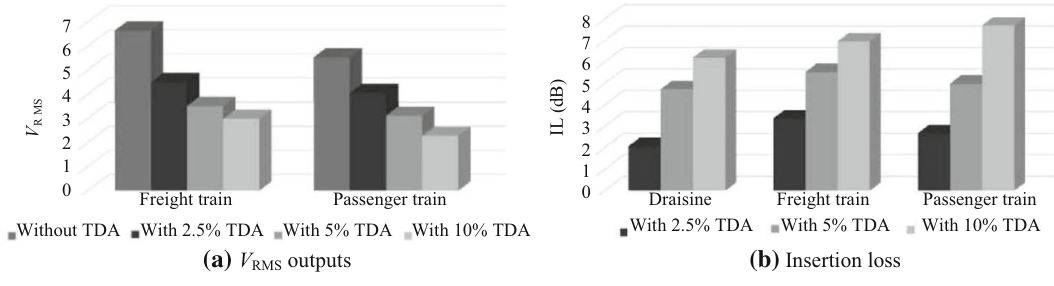
Fig. 8 Vertical component of velocity for passenger and freight trains: a V RMS outputs, b insertion